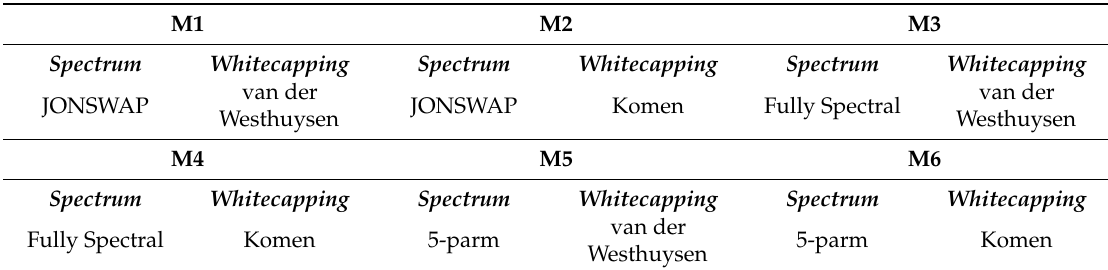
Table 3. Description of the various permutations used in the present study to investigate the best combinations of whitecapping formulation and swell boundary